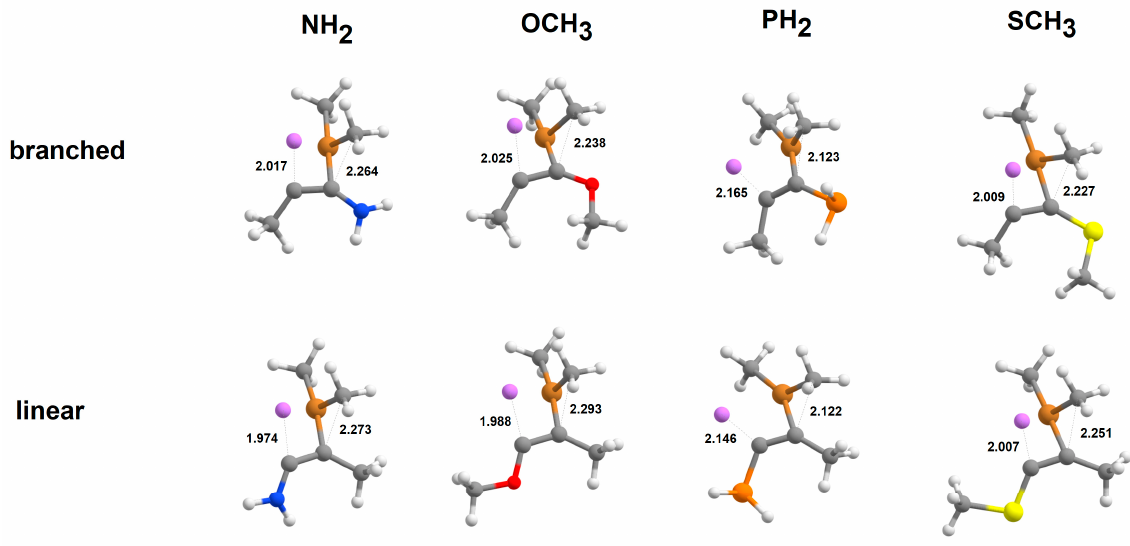
Figure 5. Transition state geometries for the methyl transfer from Cu(CH 3 ) 2 · Li to alkynes of the form R-C ≡ C-CH 3 .